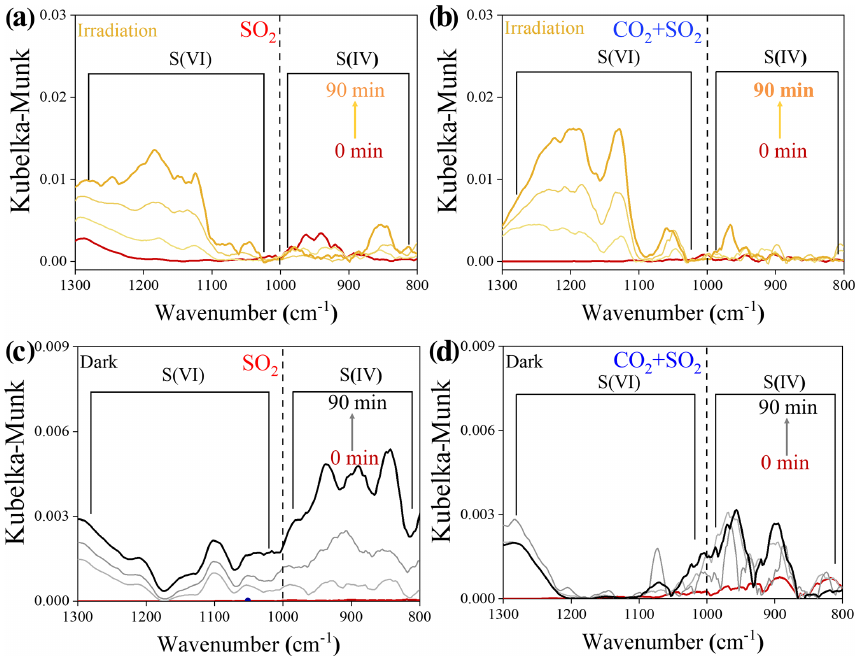
Figure 5. Time-resolved DRIFTS of S(IV) and S(VI) products over TiO 2 particles after exposure to SO 2 / N 2 + O 2 in the absence and presence of CO 2 upon irradiation (a, b) and those reactions under dark experiments (c, d) . Reaction conditions are RH of 30%, light intensity ( I ) of 30mWcm − 2 , total flow rate of 52.5mLmin − 1 , and SO 2 of 7.37 × 10 13 molec.cm − 3 .